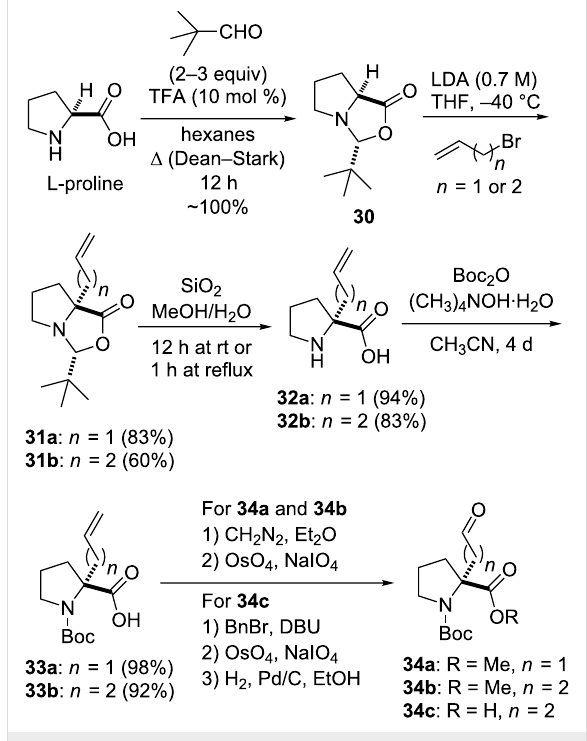
Figure 5: Spiro-bicyclic PLG peptidomimetics.